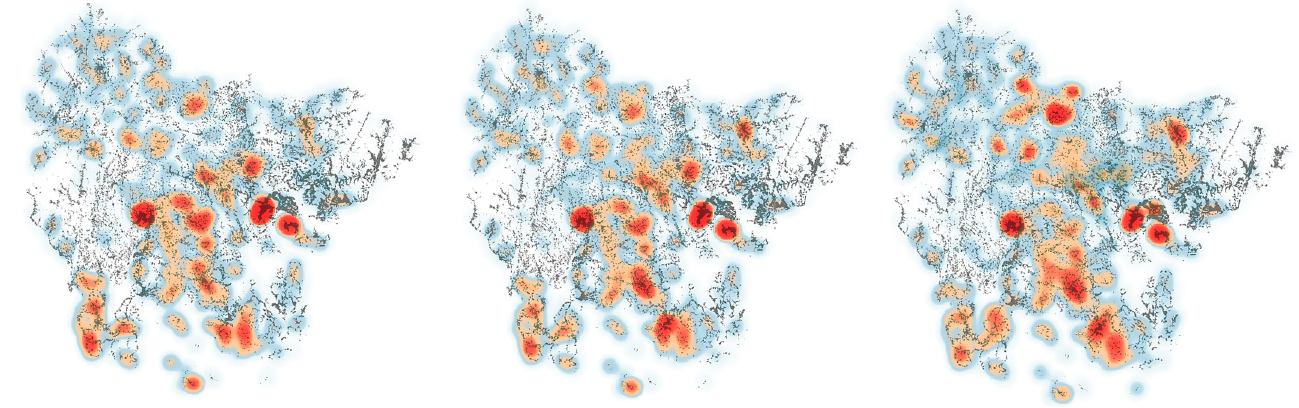
Figure 4. Clusters of abandoned houses in submunicipal divisions in Gyeongsangnam-do (2017–2019).